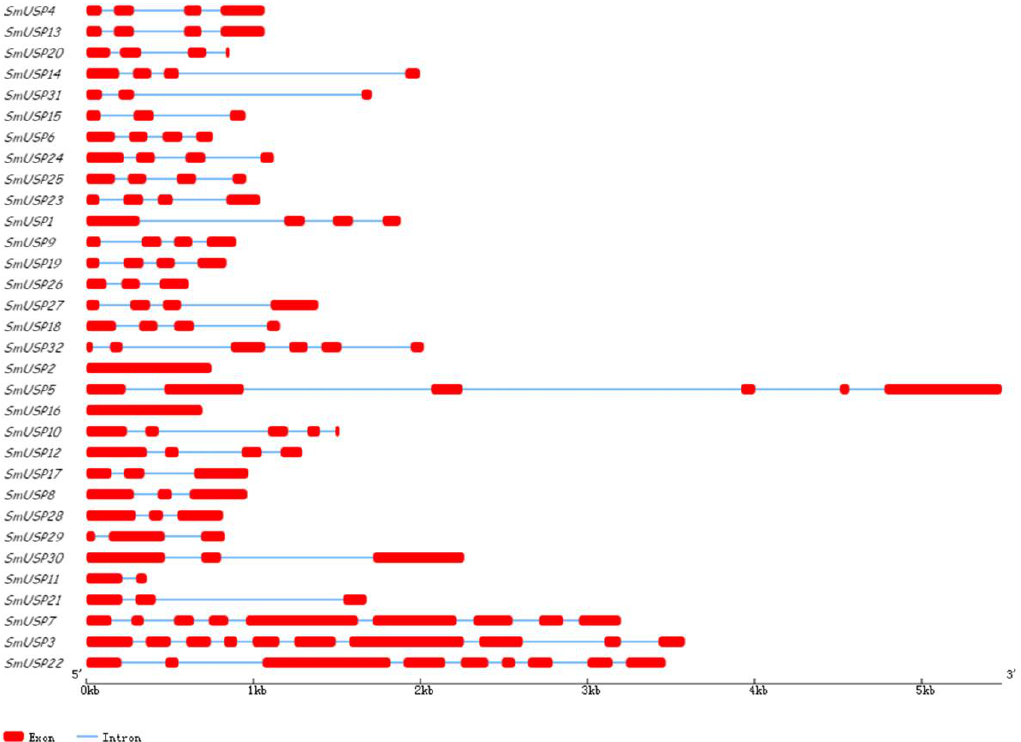
Figure 4. Exon–intron organization structures of 32 SmUSP s. Exons are represented by red, round-cornered rectangles; blue lines connecting 2 exons represent introns. Numbers above lines indicate intron phases.